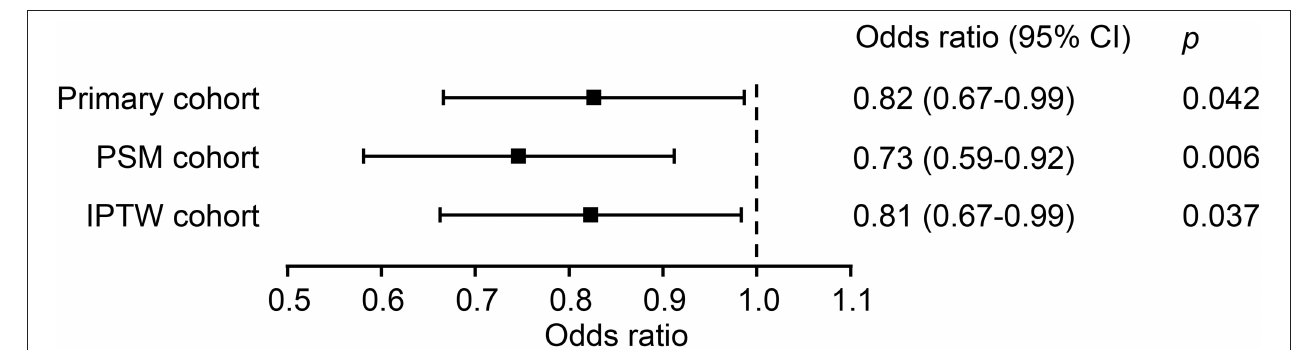
Frontiers in Cardiovascular Medicine |